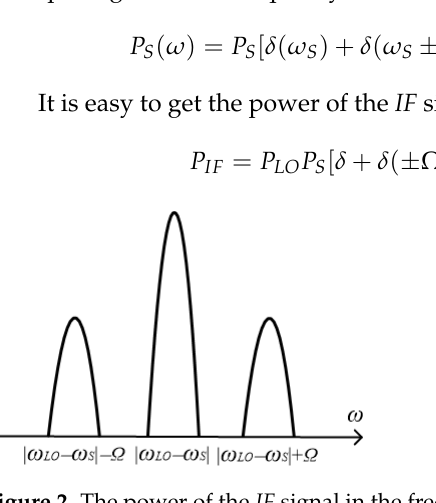
Figure 2. The power of the IF signal in the frequency domain.